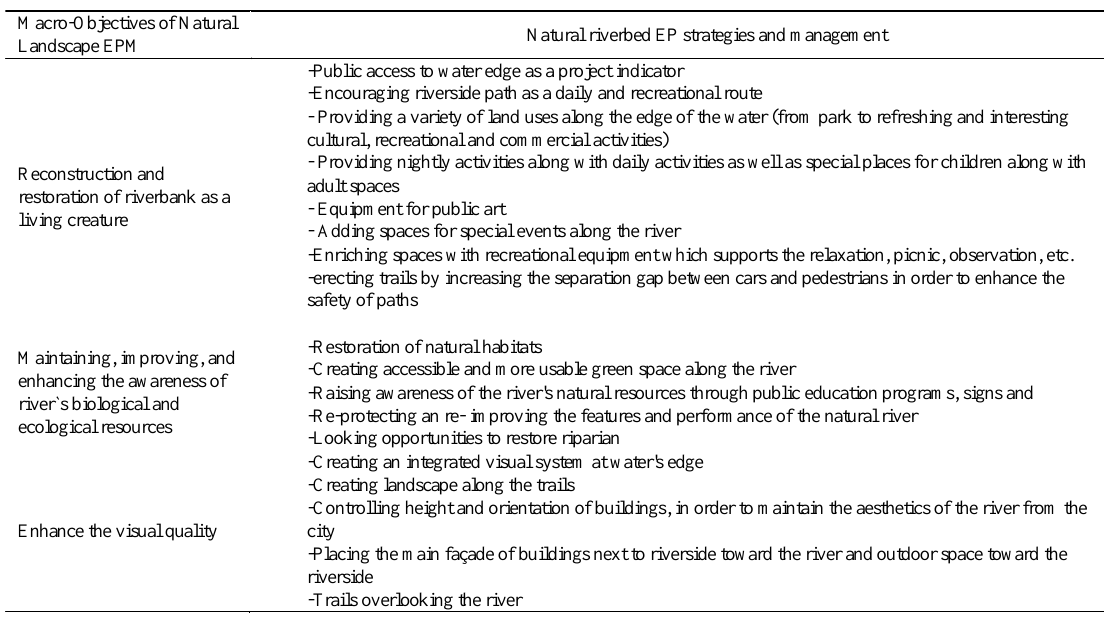
Table 5: Recommendations to organize natural landscapes of Khoshk River, Shiraz,